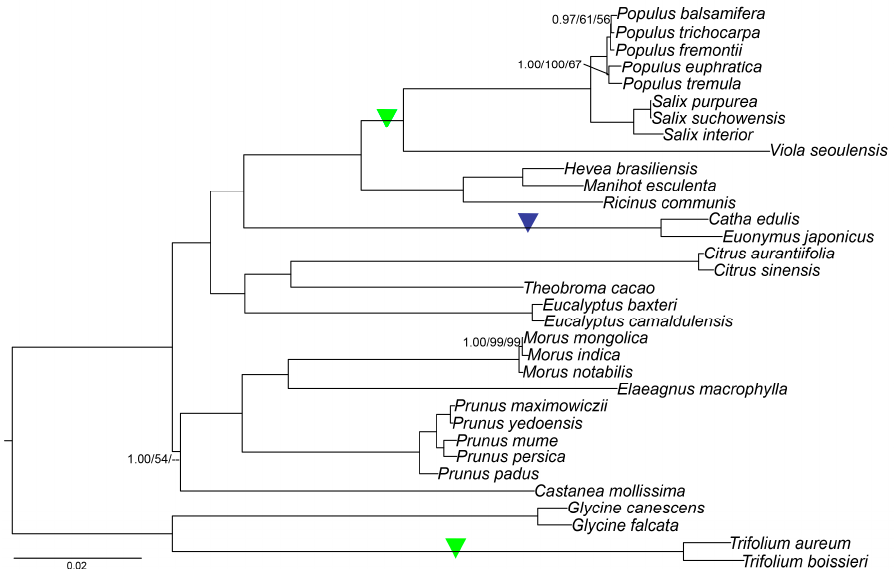
Figure 6. Phylogenetic tree based on 73 shared protein-coding genes was constructed for 33 species using three different methods, including Parsimony analysis, maximum likelihood (ML) and Bayesian inference (BI). All branches had bootstrap values or posterior probability of 100/1.00 except those labeled. The rps16 gene losses are indicated with green triangles and the rps16 intron loss is indicated with a purple triangle.